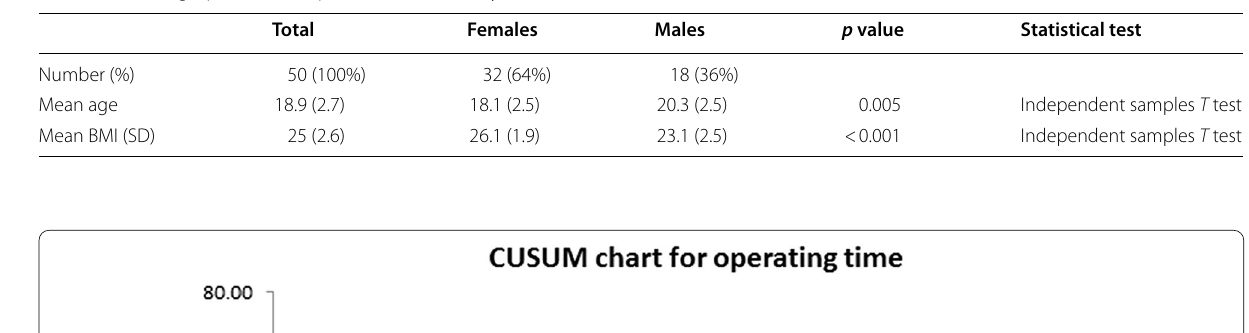
Table 1 Demographic data of patients in the study